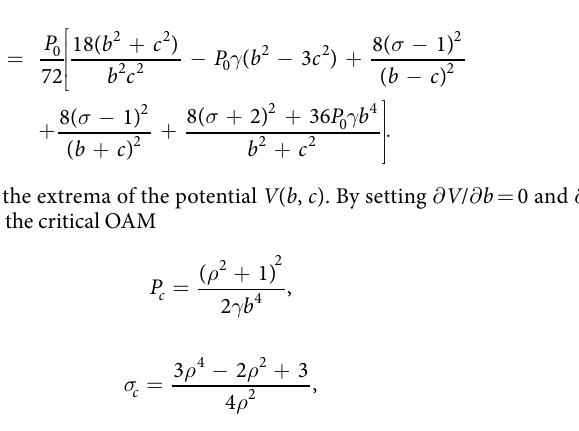
respectively, and M c = P c σ c , where ρ = b / c represents the ellipticity of the elliptic beam. Substitution of the critical power (13) and the critical OAM (14) into the expression of the angular velocity (11) yields